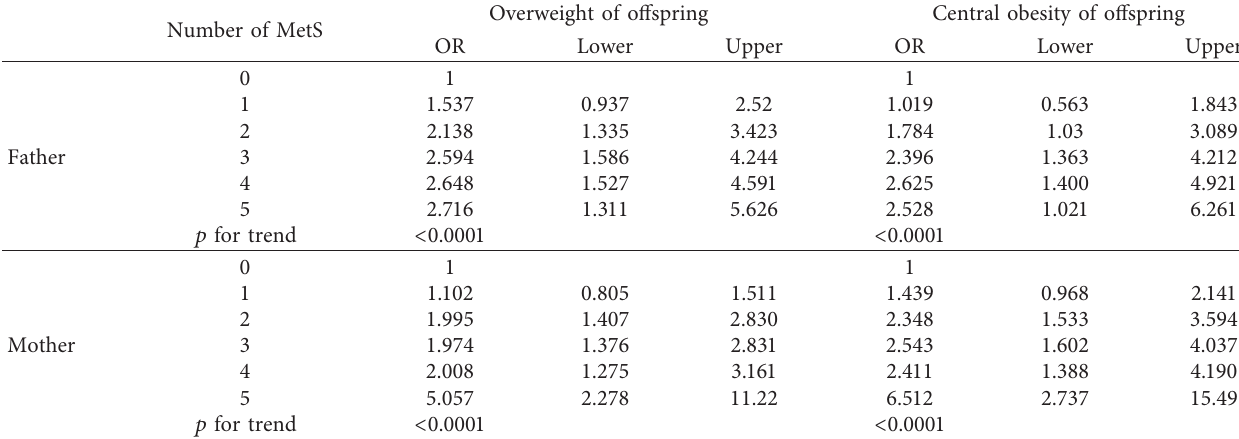
Table 4: Multivariate logistic regression analyses of overweight status and central obesity offspring according to the number of metabolic risk factors of the